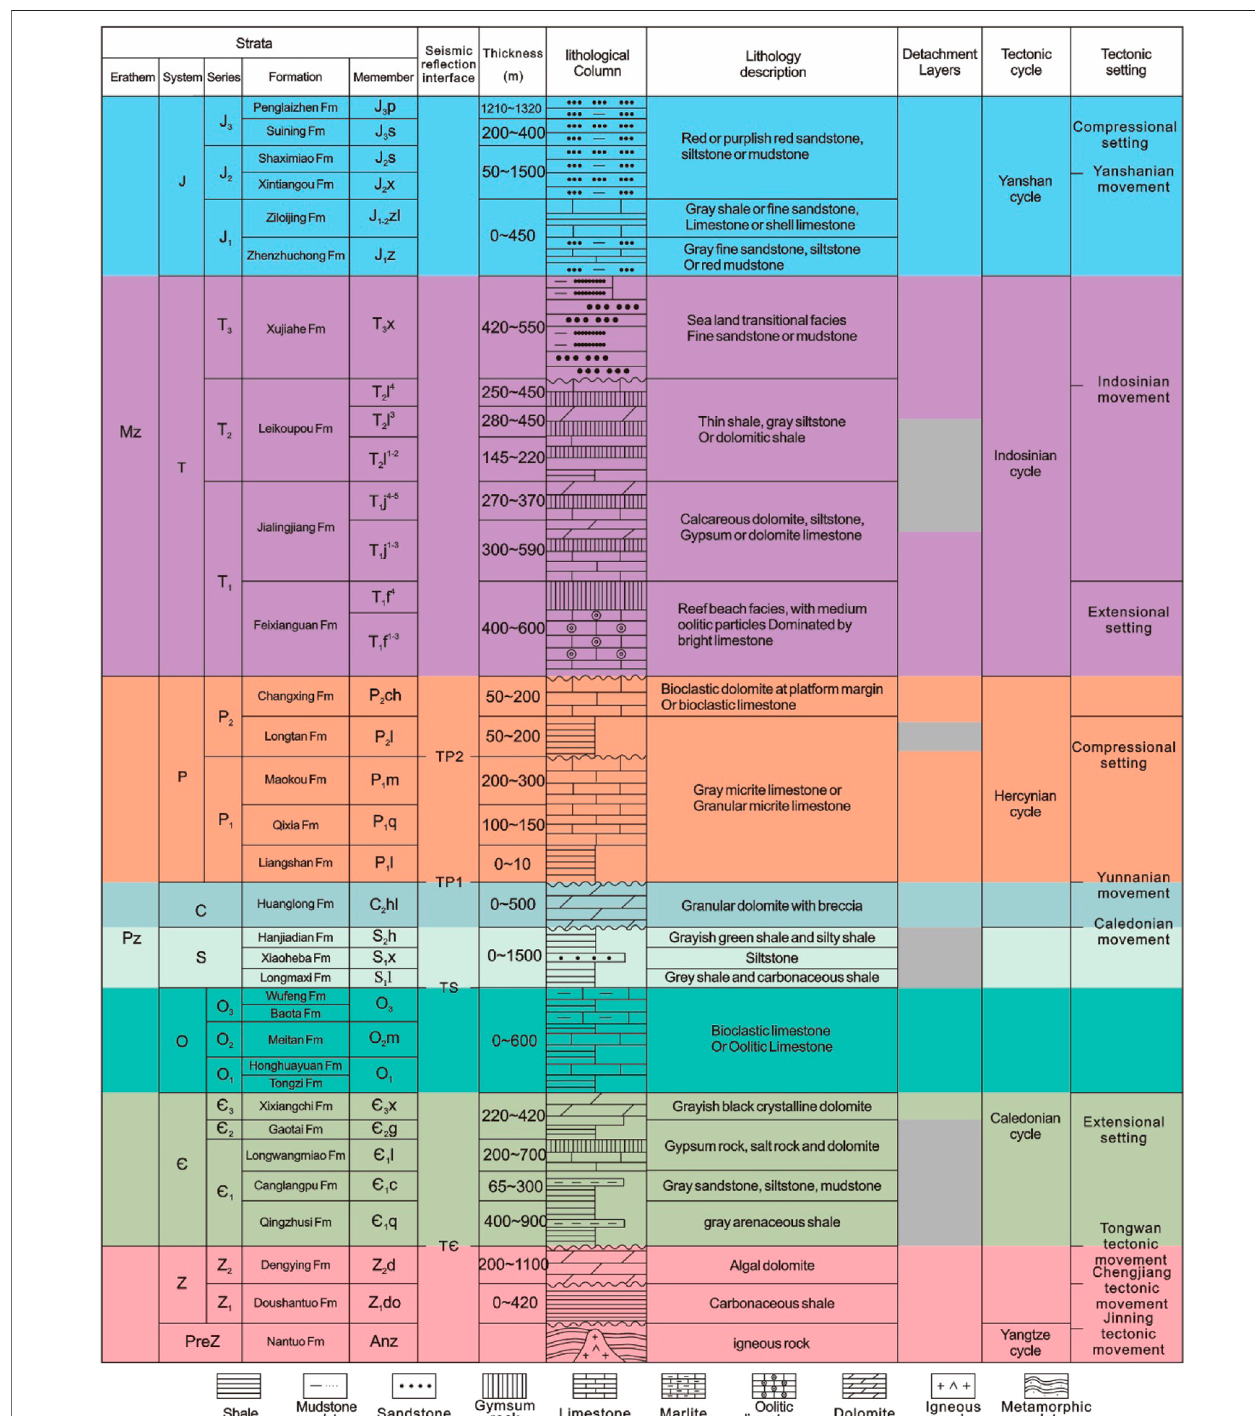
FIGURE 1 | Generalized stratigraphy, seismic re fl ecting surfaces, and tectonic movements of the Sichuan Basin (revised after Li et al., 2020).